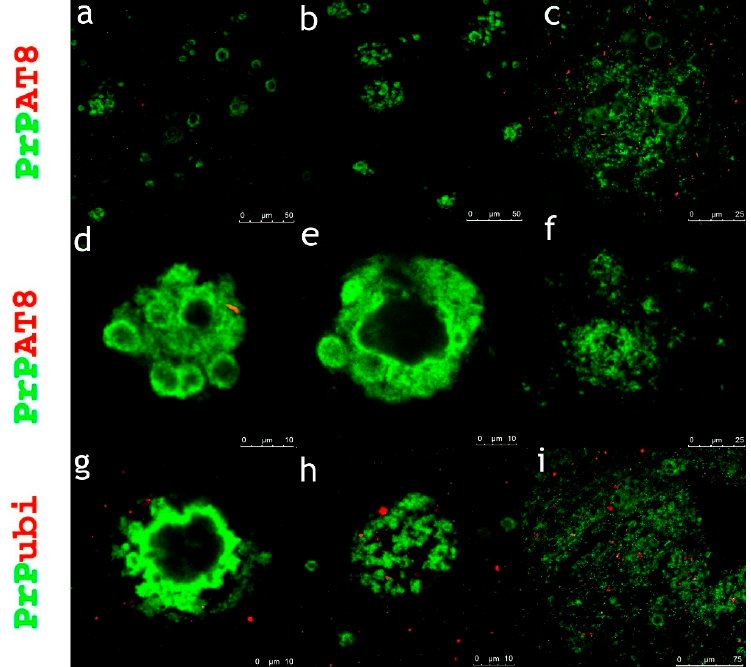
Figure 3. Condensed PrP aggregates as the dominant observation in GSS subjects. The dominant finding across the cohort was no or negligible co-aggregates with hyperphosphorylated protein tau and ubiquitin. Primary antibodies: PrP (rabbit recombinant monoclonal antibody, green color) + AT8 (mouse monoclonal antibody, red color), ubiquitin (mouse monoclonal antibody, red color). The secondary antibody was conjugated with either Alexa Fluor ® 488 (anti-rabbit IgG, green) or Alexa Fluor ® 568 (anti-mouse IgG, red). Scale bars indicate 50 µm in ( a , b ), 25 µm in ( c , f ), 10 µm in ( d , e , g , h ), and 75 µm in ( i ).